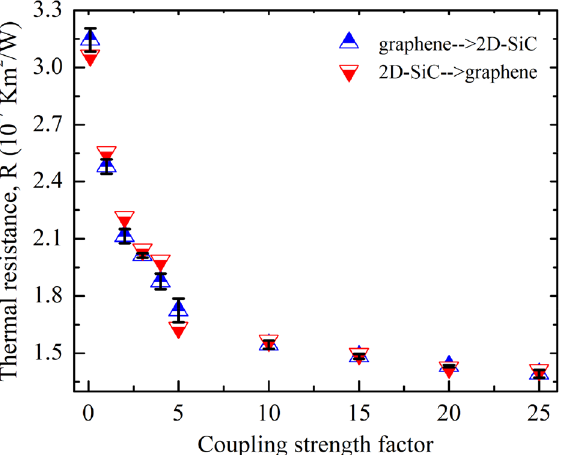
Figure 12. Interfacial thermal resistance variations with different coupling strength factors from 0.1 to 25. There is no thermal rectification observed in the out-of-plane thermal conduction for different coupling